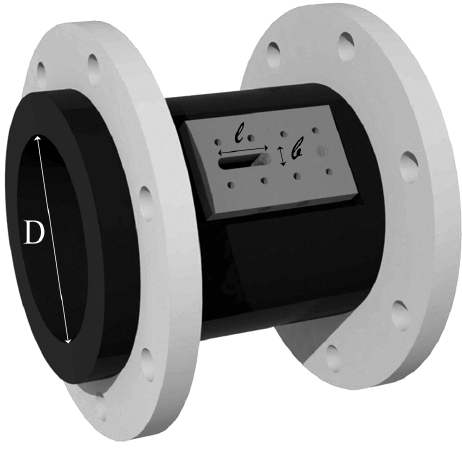
Figure 3. Device used to simulate